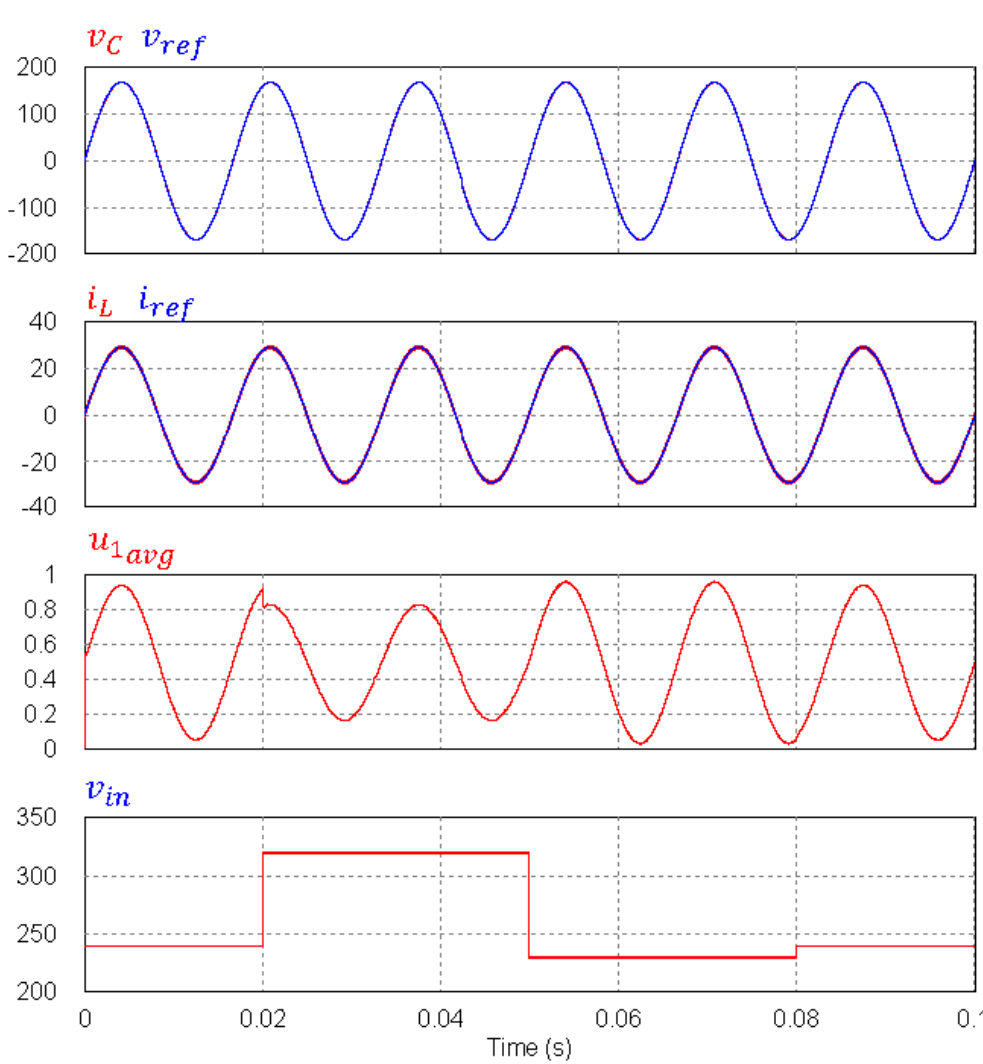
Figure 2. Simulated waveforms of the full-bridge inverter feeding a resistive